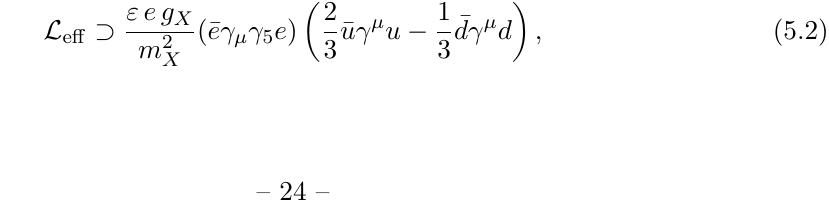
Figure 6 . Parameter space for the light X solution to the ( g − 2) µ anomaly in the The shaded regions are excluded by various experiments, while the region between the black lines is preferred by ( g − 2) at 2 σ . See section 5 for µ